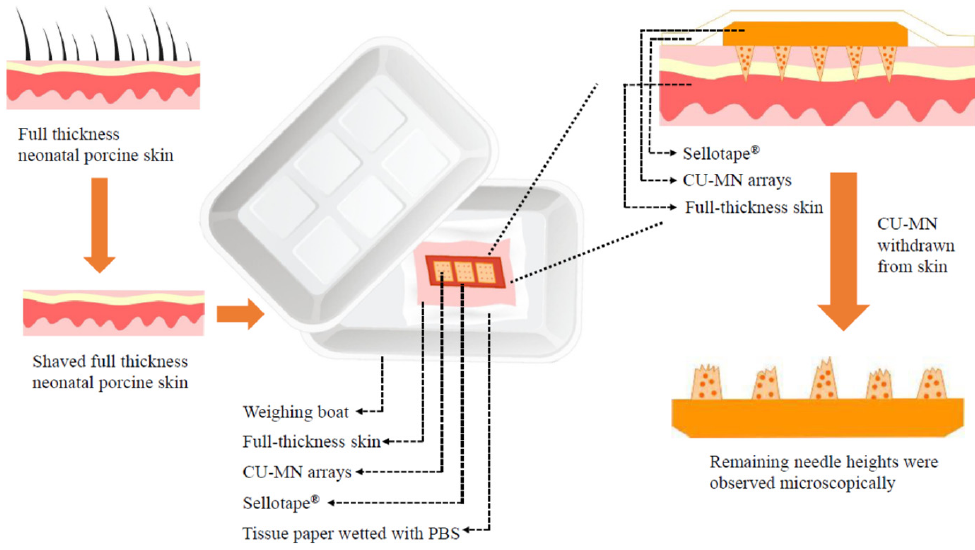
Figure 2. Schematic representation of the set-up used to study dissolution of curcumin nanosuspension-loaded microneedle arrays (CU-MN) in full-thickness neonatal porcine skin in